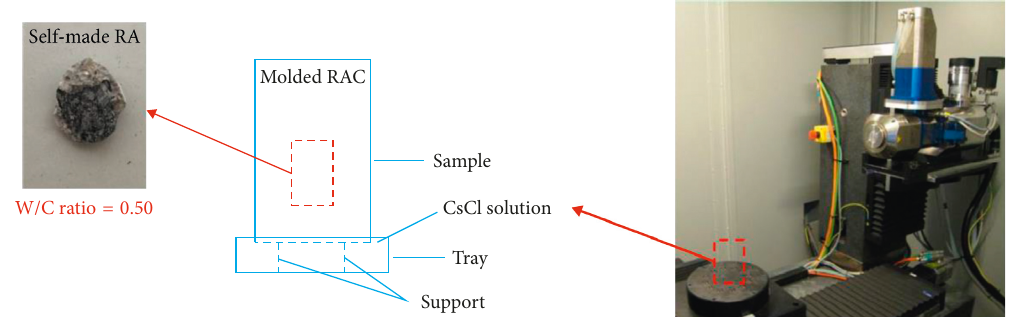
Figure 1: Experiment schematic for monitoring chloride ion penetration